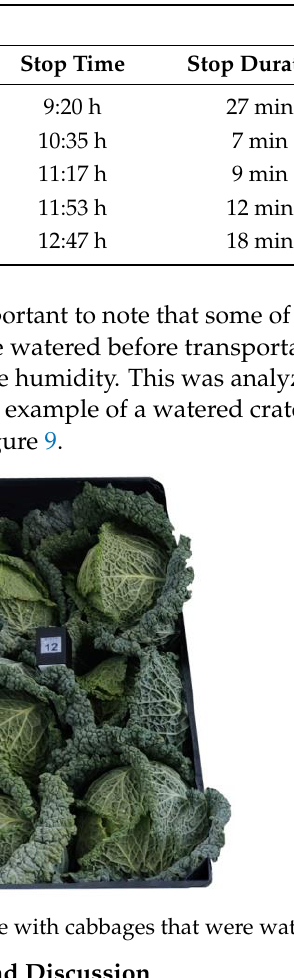
Figure 9. Crate with cabbages that were watered prior to loading in the truck.